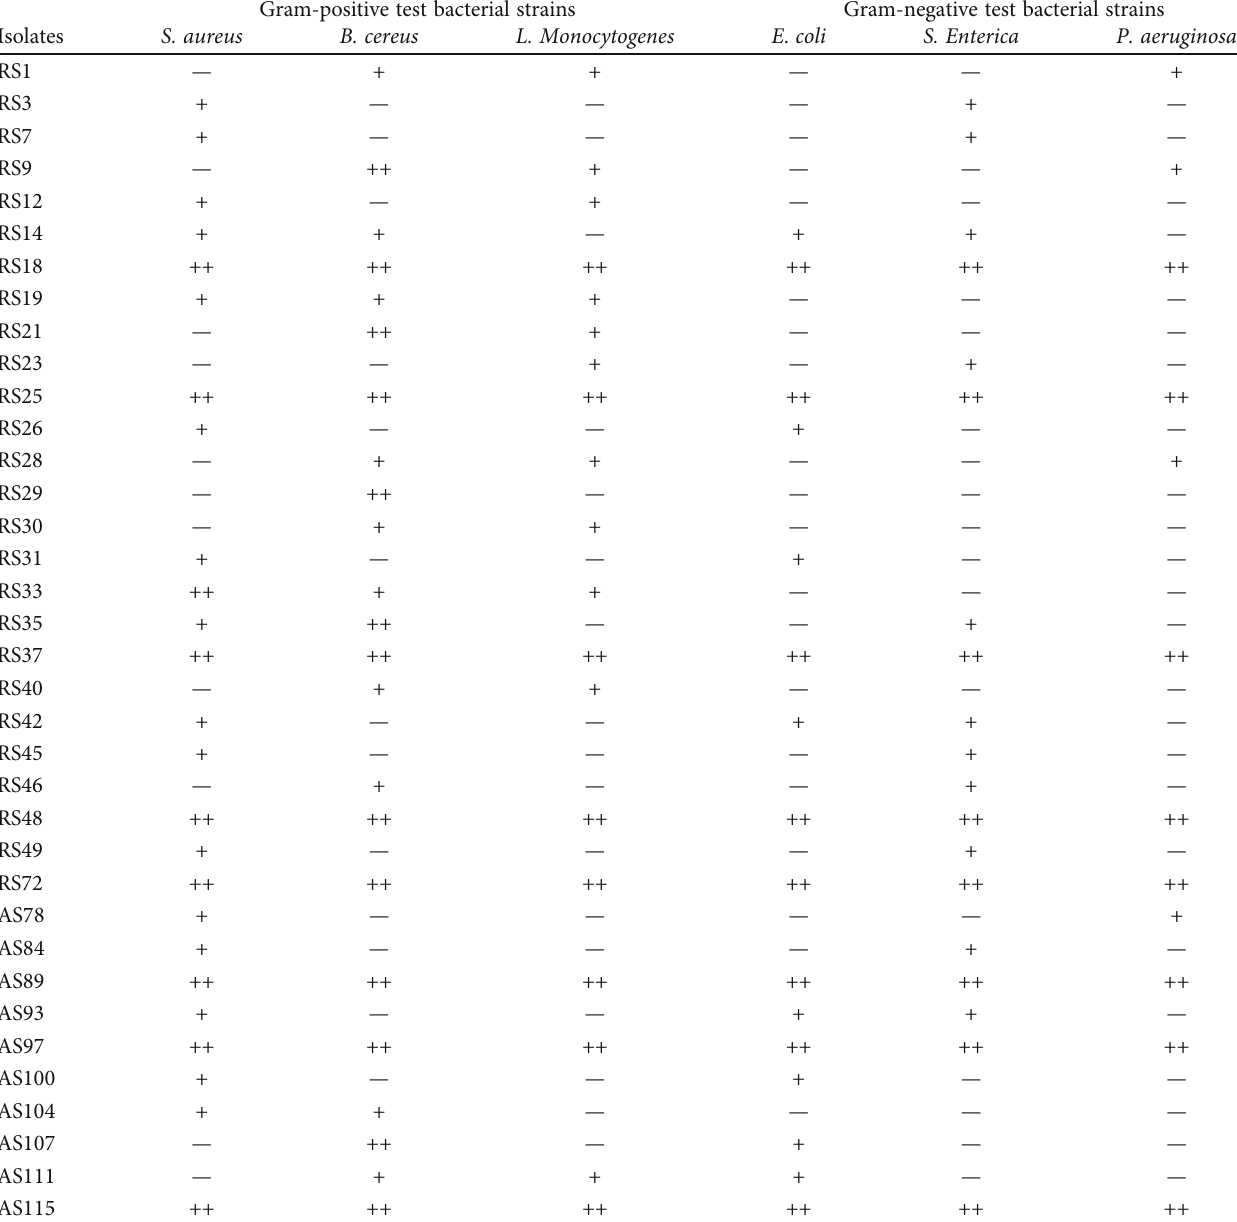
Table 1: Primary screening of actinomycete isolates for antimicrobial compound production against spoilage and foodborne bacterial